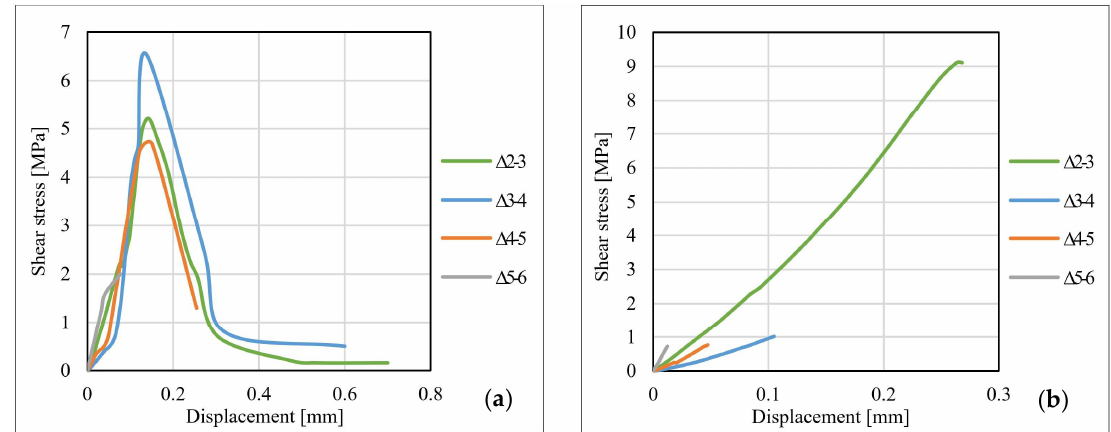
Figure 13. Bond–slip curves for specimens: ( a ) S-S512-30-2-I and ( b ) S-S512-330-1-II.